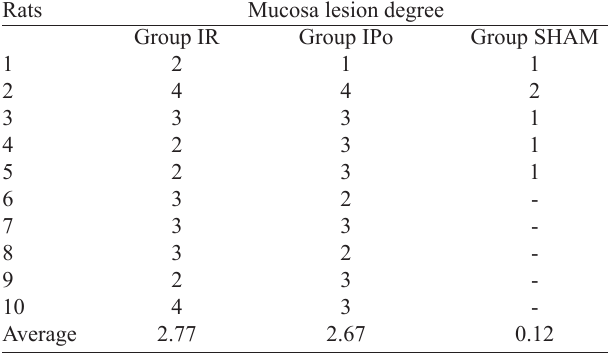
Table 1. Results of the histological analysis of the injury degree of the intestinal mucosa of rats according to Chiu et al. 11 .